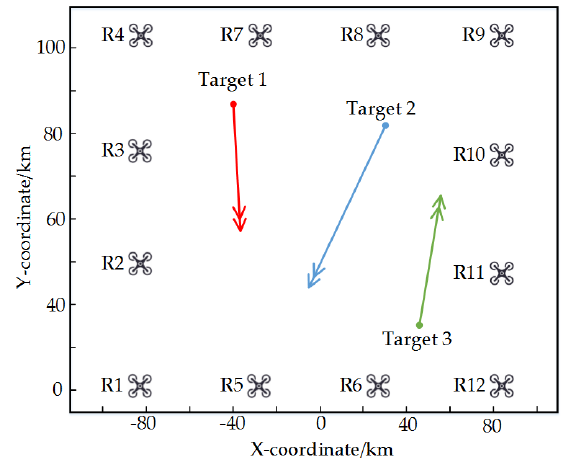
Figure 6. The distribution of radars and targets.